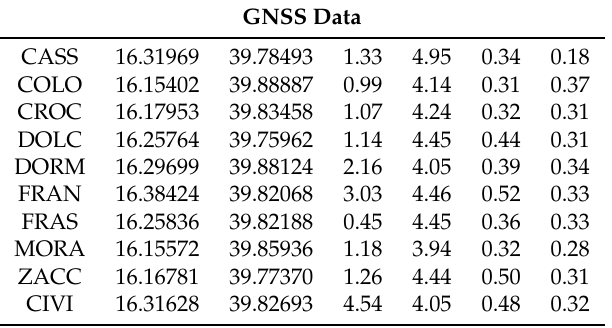
Table 2. Site id, longitude, latitude, east and north component of estimated GNSS velocities and